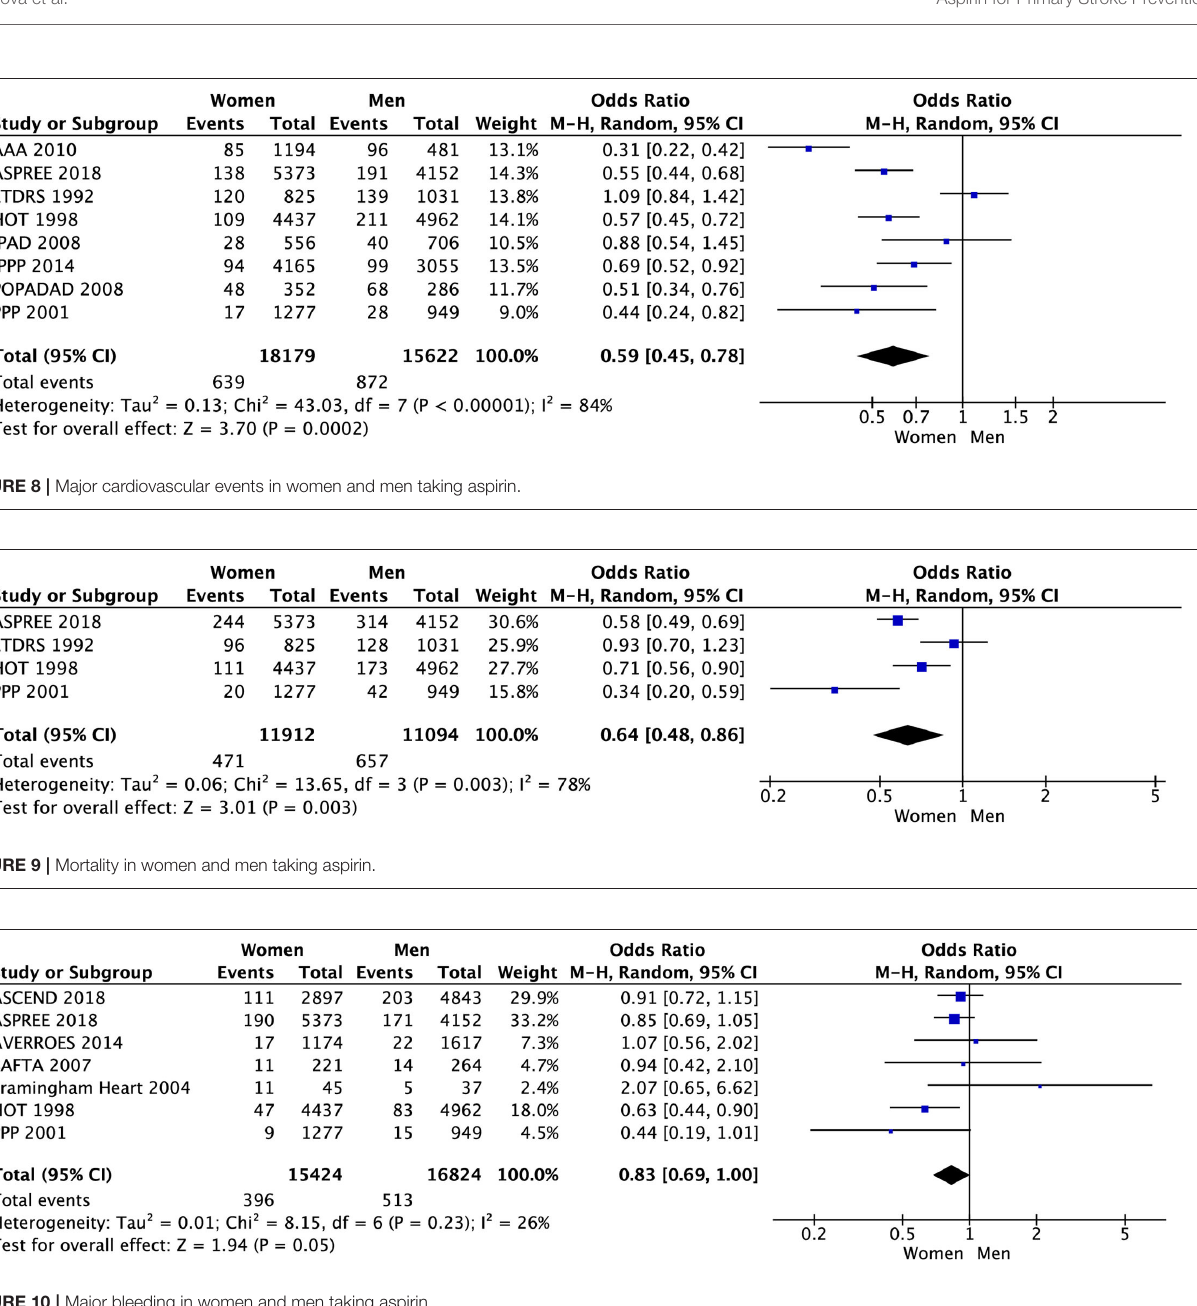
FIGURE 10 | Major bleeding in women and men taking